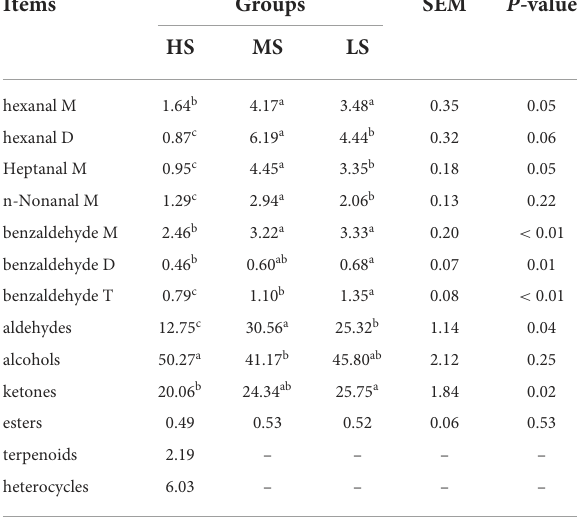
TABLE 5 Effect of different energy level diets on the amino acid composition in the longissimus lumborum of Tibetan sheep (mg/100g